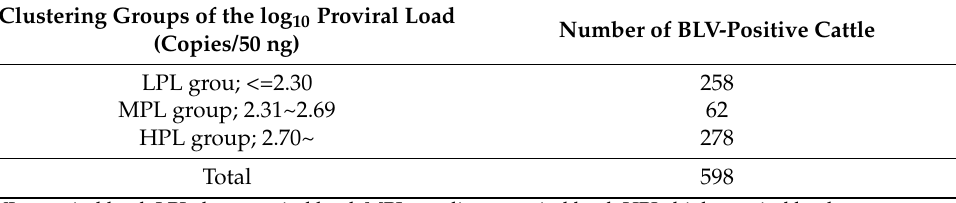
Figure 1. Histogram (log 10 ) showing the PVLs associated with BLV infections in the study cattle population. The histogram graphically summarizes and displays the frequencies and left skewed distribution of the log 10 BLV PVLs (copies/50 ng). Table 2. Hierarchical clustering groups for the BLV-associated log 10 PVLs based on Euclidean distance